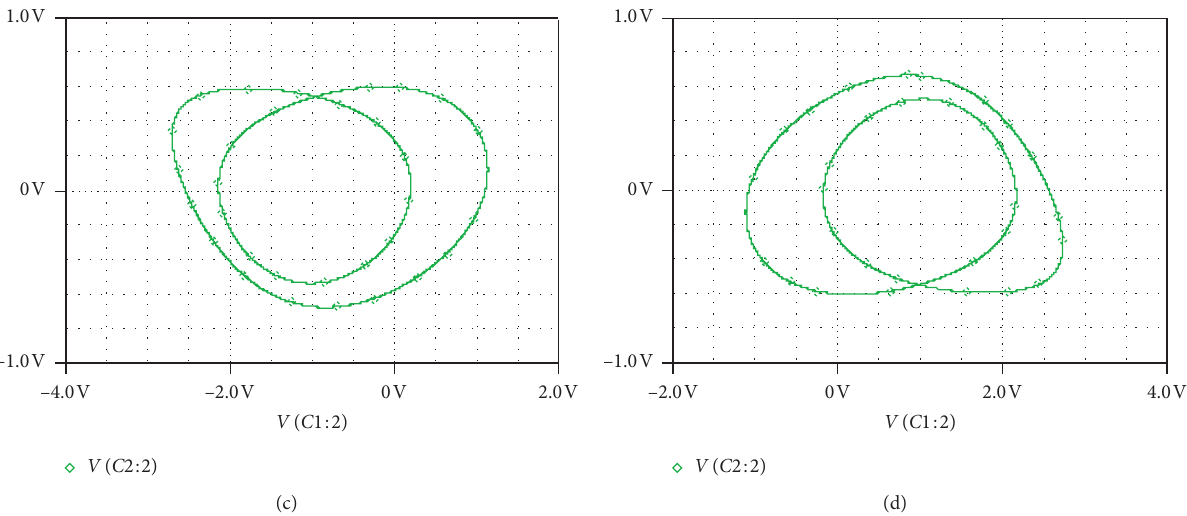
Figure 11: Phase portraits showing the coexistence of four different attractors using PSpice simulation (a pair of periodic and a pair of chaotic) for R c � 133 . 178 K Ω ; initial conditions are ( ± 4 . 3 V , ± 0 . 11 V , 0V ) for the chaotic pair and ( ± 4 . 3 V, ± 0V , ± 0V ) for periodic attractors.